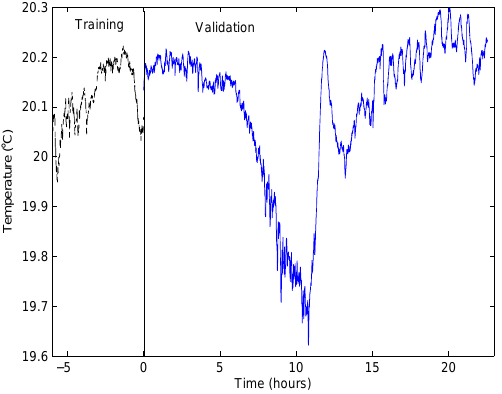
Figure 18. Temperature evolution in training and validation phases.